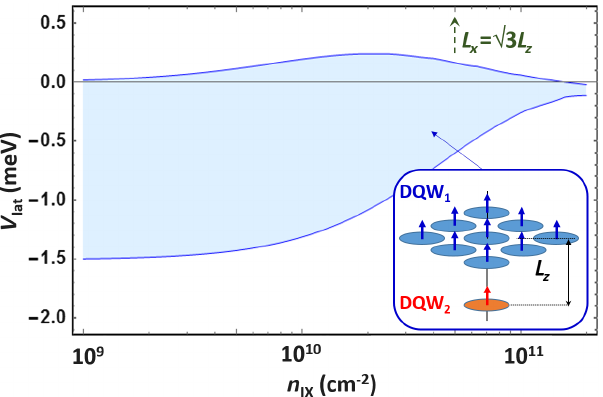
FIG. 9. Range of energies (shaded region) spanned by the inter- DQW interaction between a single IX in DQW 2 and a closed- packed triangular lattice of IXs with density n in DQW 1 , as IX illustrated in the inset. n is related to the triangular IX